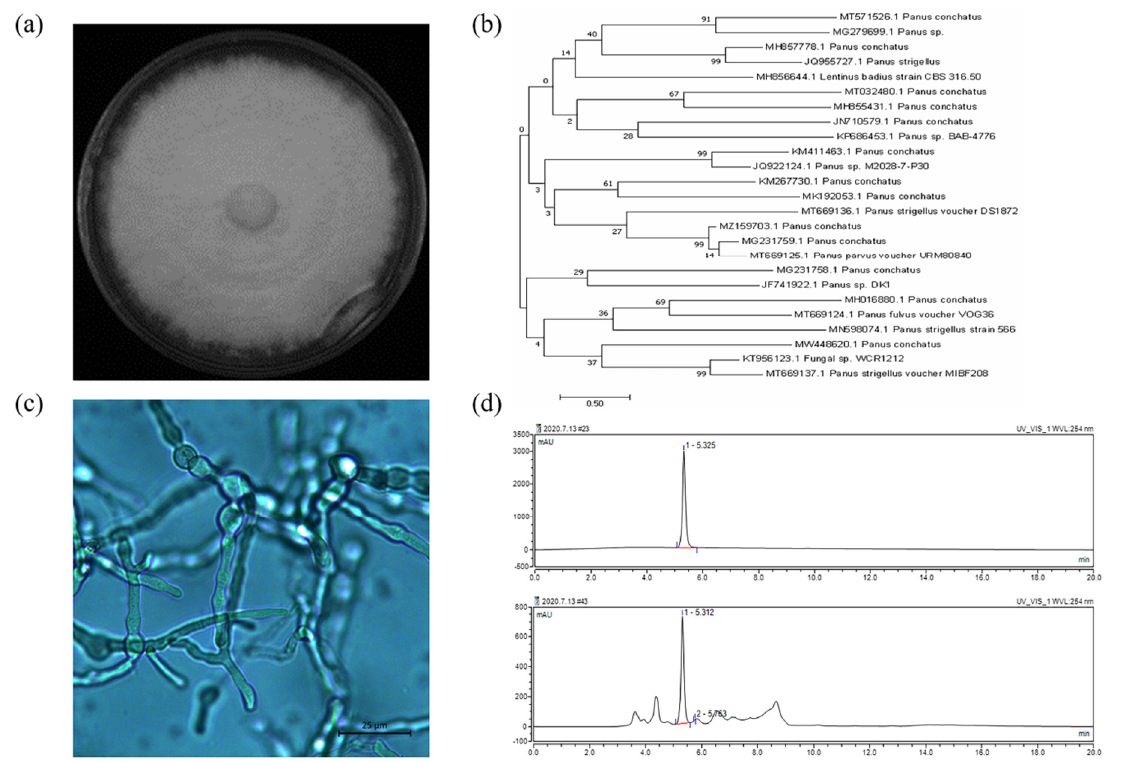
Figure 2. Fungal colony and product identification ( a ) Panus conchatus colony; ( b ) Phylogenetic tree of the Panus conchatus ; ( c ) Panus conchatus mycelial morphology ( a ) LEICA DM1000, 40 × magnification); ( d ) Liquid chromatogram for product determination (The top is the peak of the standard, and the bottom is the peak of the extract). Table 1. Effect of different kinds of nitrogen sources on EGT